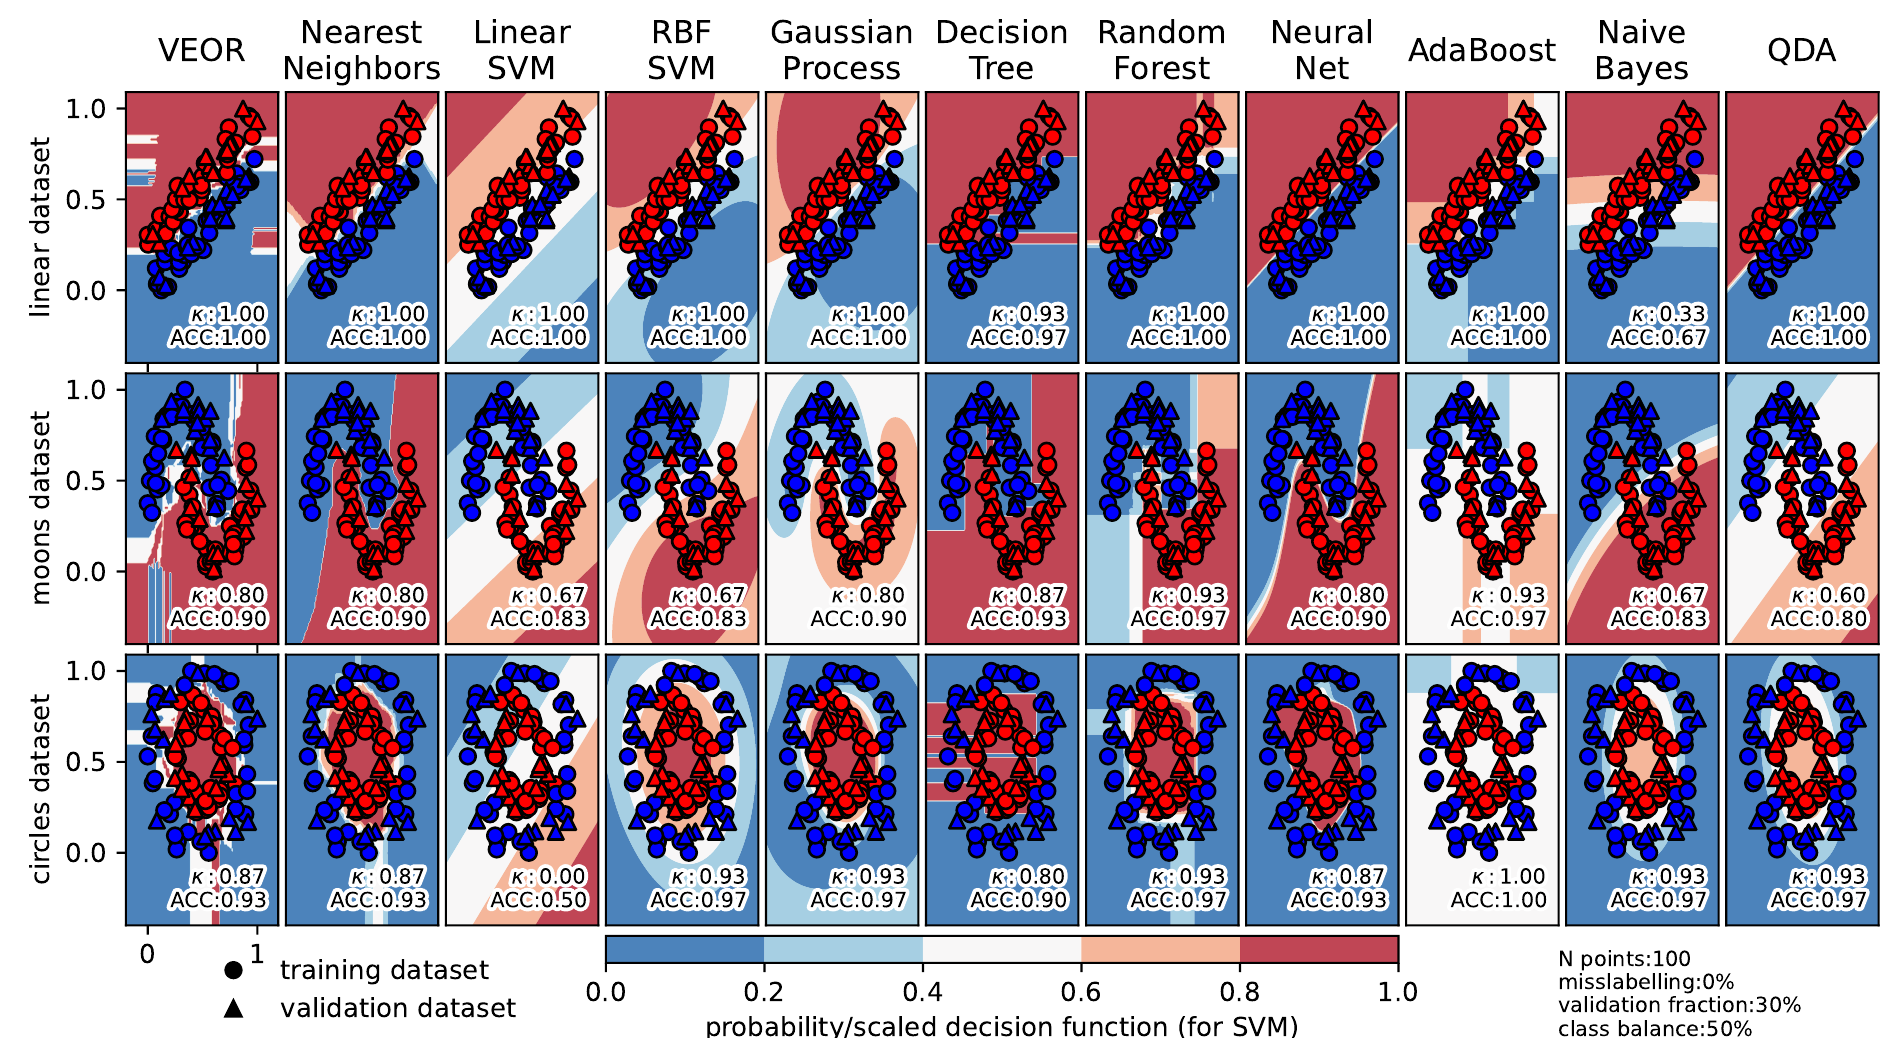
Figure 4. Comparison of classifier performance for a single experiment with synthetic 2D datasets with a 50%/50% class balance and without